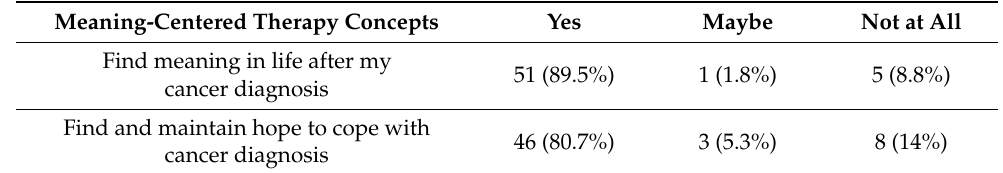
Table 7. Meaning-centered psychotherapy concepts: